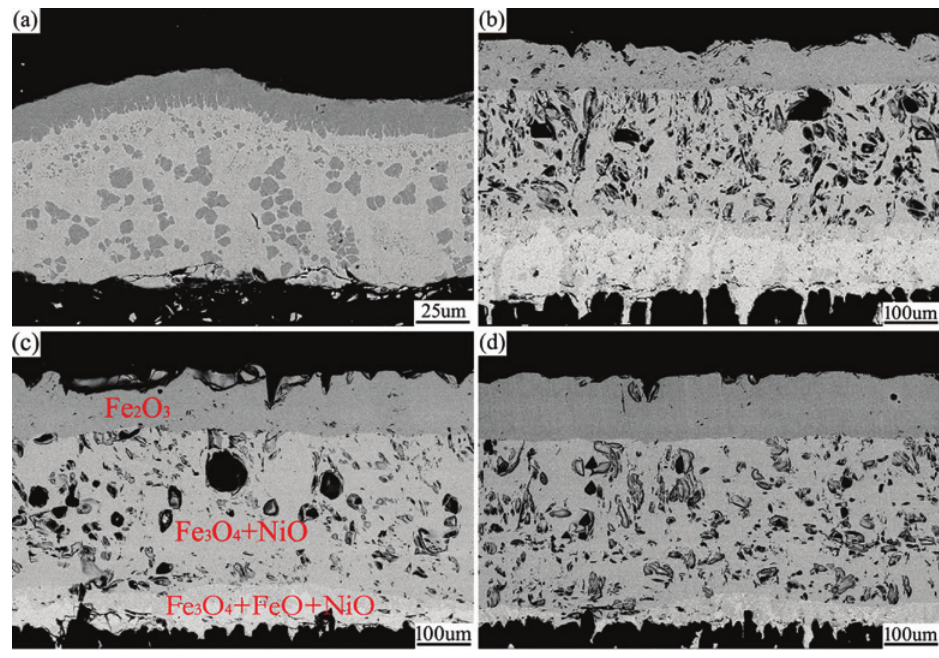
Fig. 2: Cross section morphology of the external scale: (a) 0%O 2 , (b) 3%O 2 , (c) 5%O 2 , (d) 6%O 2